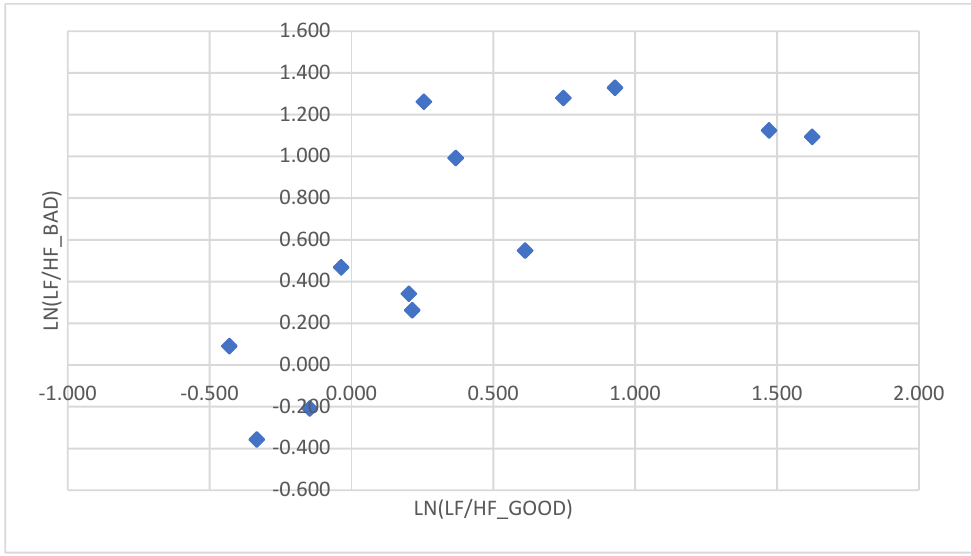
Figure 26. The ratios of the natural logarithms of the mean values of the vegetative balance index in different blocks in the Basic Set.